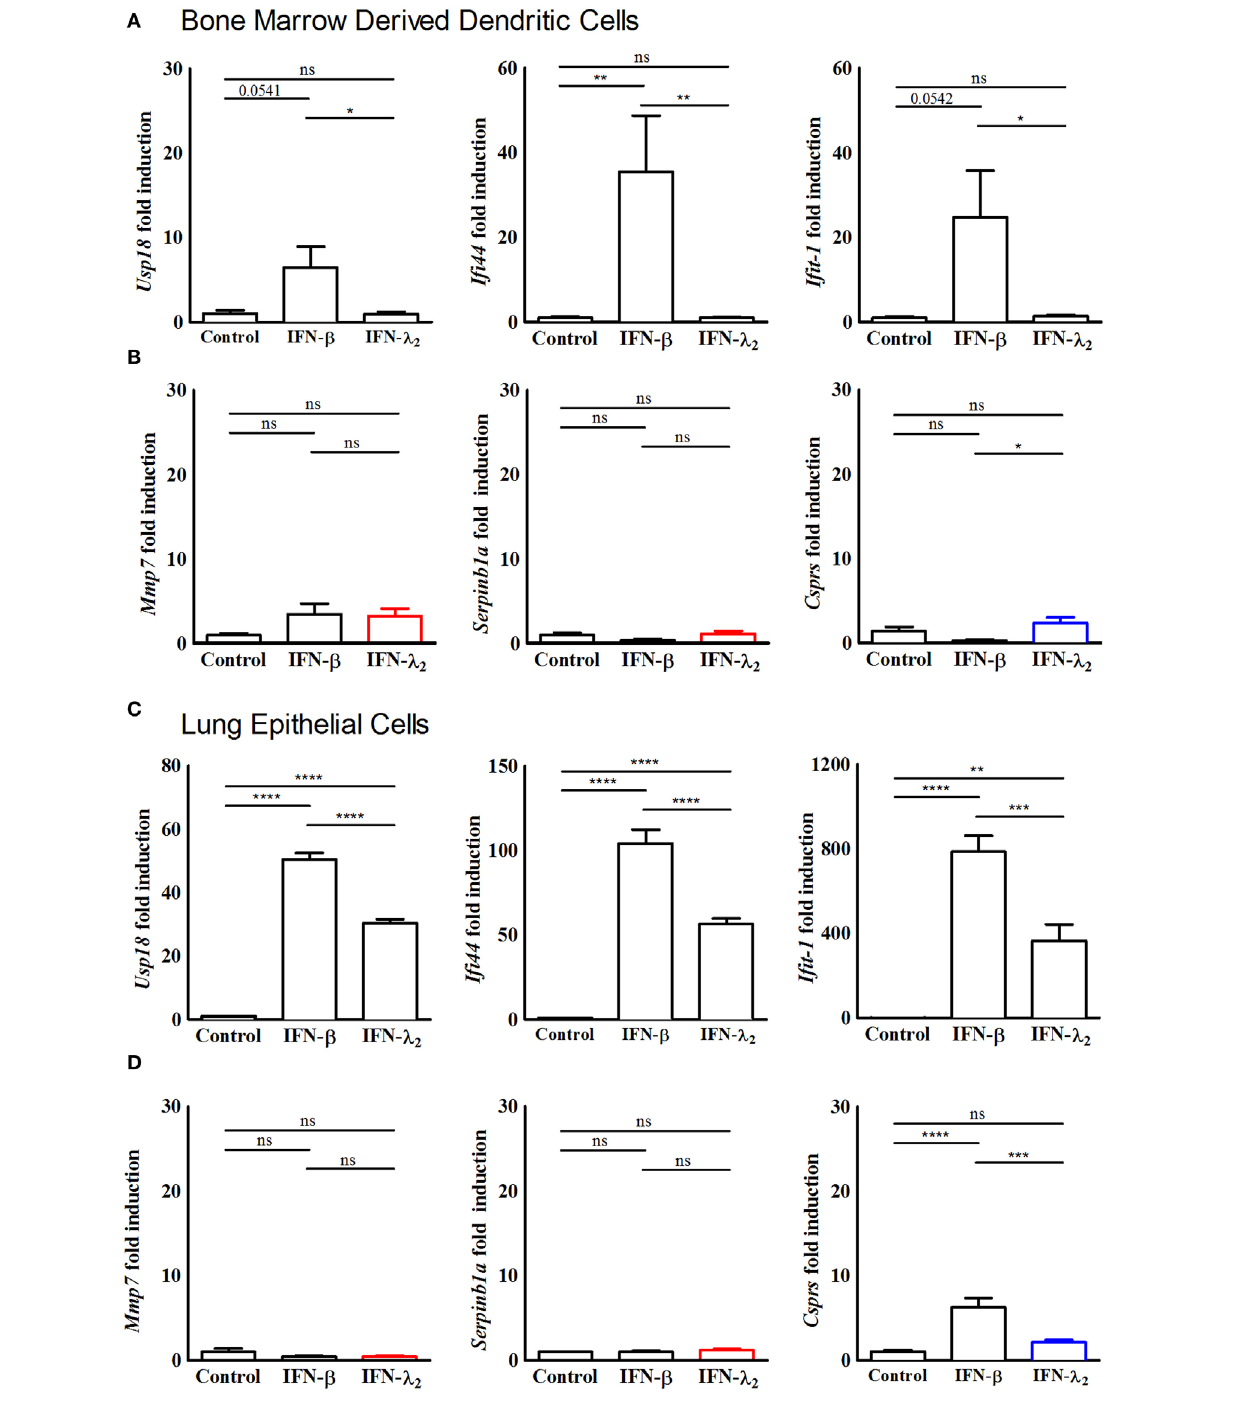
FigUre 3 | Predominantly interferon (IFN)- λ -induced genes are not induced in bone marrow-derived dendritic cells and primary lung epithelial cells. (a,b) Quantitative RT-PCR for (a) the prototypical IFN-stimulated genes (ISGs) Usp18 , Ifi44 , and Ifit1 and (b) the predominantly IFN- λ -induced ISGs Mmp7 , Serpinb1a , and Csprs performed on total RNA isolated from bone marrow-derived dendritic cells isolated from 8-week-old female wild-type mice and cultured in vitro for 7 days. The dendritic cells were stimulated with Flt3 ligand to initiate maturation, following which they were stimulated with IFN- λ 2 (20 ng/mL) or IFN- β (500 U/mL) for 9 h. (c,D) Quantitative RT-PCR for (c) the prototypical ISGs Usp18 , Ifi44 , and Ifit1 and (D) the predominantly IFN- λ -induced ISGs Mmp7 and Serpinb1a and Csprs performed on total RNA isolated from primary lung epithelial cells isolated from 8-week-old female wild-type mice and cultured in vitro for 5 days before stimulation for 9 h with IFN- λ 2 (20 ng/mL) or IFN- β (500 U/mL). The results are normalized to β -actin and are represented as mean ± SEM values from two independent experiments performed in quadruplicates. Statistical significance was calculated using a one-way analysis of variance (with Tukey’s